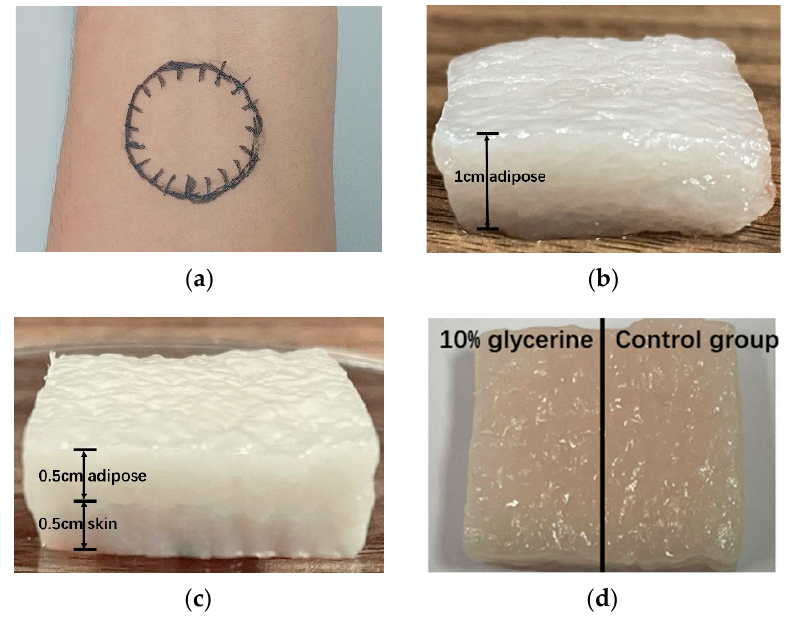
Figure 2. Tissue samples: ( a ) human inner wrist skin (anterior face), ( b ) single-layer tissue consisting of adipose layer, ( c , d ) double-layer tissue consisting of porcine skin and adipose layer. The single layer and double-layer tissues used in this study were taken from the re- gion of porcine hind legs, which were prepared 2 h after the porcine was butchered. The double-layer tissue (Figure 2c) consists of 0.5 cm thick porcine skin and 0.5 cm thick adi- pose layer. The single layer tissue (Figure 2b) was cut into a 1.5 × 1.5 cm cube of 1 cm thickness. The double-layer tissue (Figure 2c), consisting of 0.5 cm thick porcine skin and 0.5 cm thick adipose layer, was also cut into the same size as the single layer tissue, then was cut into two equal parts with a piece of plastic wrap between them (Figure 2d). Dur- ing experiments, the double-layer sample were turned upside down with the adipose layer at the top and the porcine skin at the bottom. For TOC, 10% glycerin was applied evenly to the single layer tissue and one side of the bilayer tissue for 20 s. The other side of the double-layer tissue served as a control group, since the plastic wrap prevented lat- eral diffusion of the glycerin. For both single-layer and double-layer tissues, we cleaned the surface glycerin and measured them continuously for one hour. 2.3. Polarization Parameters Our previous work has demonstrated that Mueller matrix and polarization parame- ters can be used as effective tools to study the microstructural variation due to interaction between clearing agents and biological tissues [28,29]. The elements of MM contain abun- dant polarization information of tissue. However, the relationship of a single MM element to a particular microstructure is unclear, so it is useful to extract polarization parameters from MM elements to quantitatively characterize the microstructure information of the sample [12,30]. In this work, we adopted Mueller matrix transformation (MMT) parameter b [31] to reflect the process of TOC, which relates to depolarization. Parameter b has been used in monitoring microstructural variations of fresh skeletal muscle tissues [32], probing lay- ered structures by multi-color backscattering polarimetry [16]. In addition, we also ap- plied MMT parameter t 1 and Mueller matrix polar decomposition (MMPD) parameter D to the error analysis at different times of single MM measurements, which respectively represent anisotropy and diattenuation of the sample [33]. The equation expressions for the polarization parameter are shown in Equation (2). 𝑏 = 𝑀22 (cid:3397) 𝑀33 2 𝑡1 = (cid:4666)𝑀22 (cid:3398) 𝑀33(cid:4667) (cid:2870) (cid:3397) (cid:4666)𝑀23 (cid:3397) 𝑀32(cid:4667) (cid:2870) 4 𝐷 = (cid:3493)𝑀12 (cid:2870) (cid:3397) 𝑀13 (cid:2870) (cid:3397) 𝑀14 (cid:2870) (2) 2.4. Monte Carlo (MC) Simulation Due to the complexity of biological tissues, Monte Carlo (MC) simulation has been widely used in previous works to help us understand the microstructural changes and the